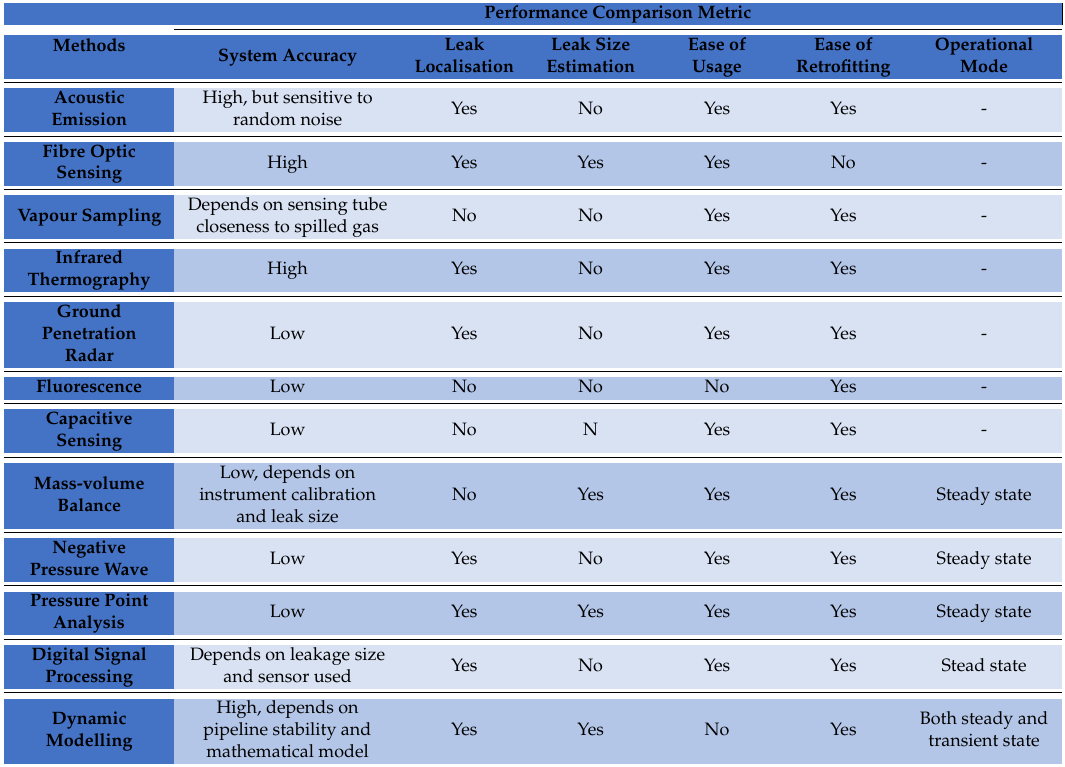
Table 3. Two-level performance analysis